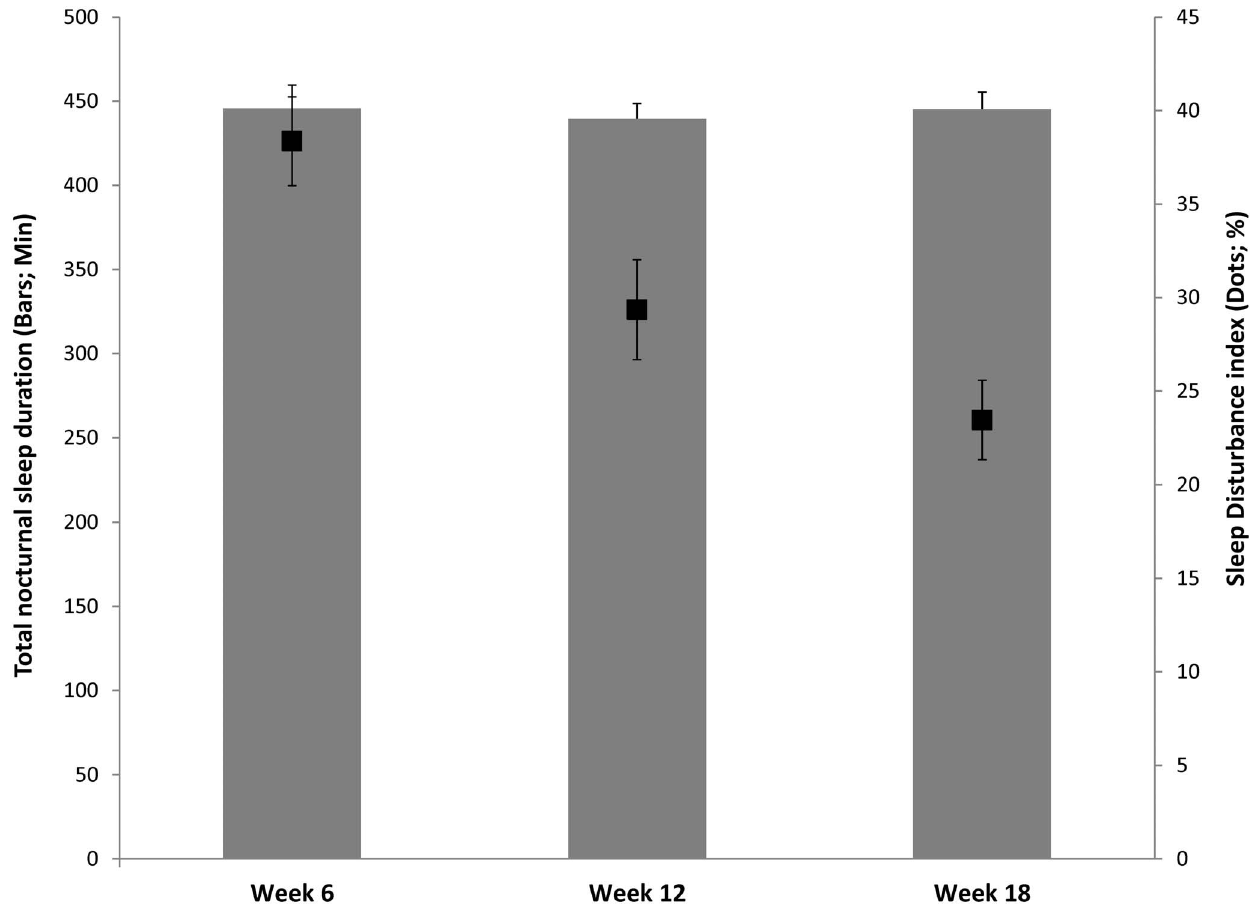
Figure 1. Postpartum nocturnal sleep duration (minutes) and sleep disturbance index (%), error bars represent standard error. doi:10.1371/journal.pone.0103513.g001 PLOS ONE |